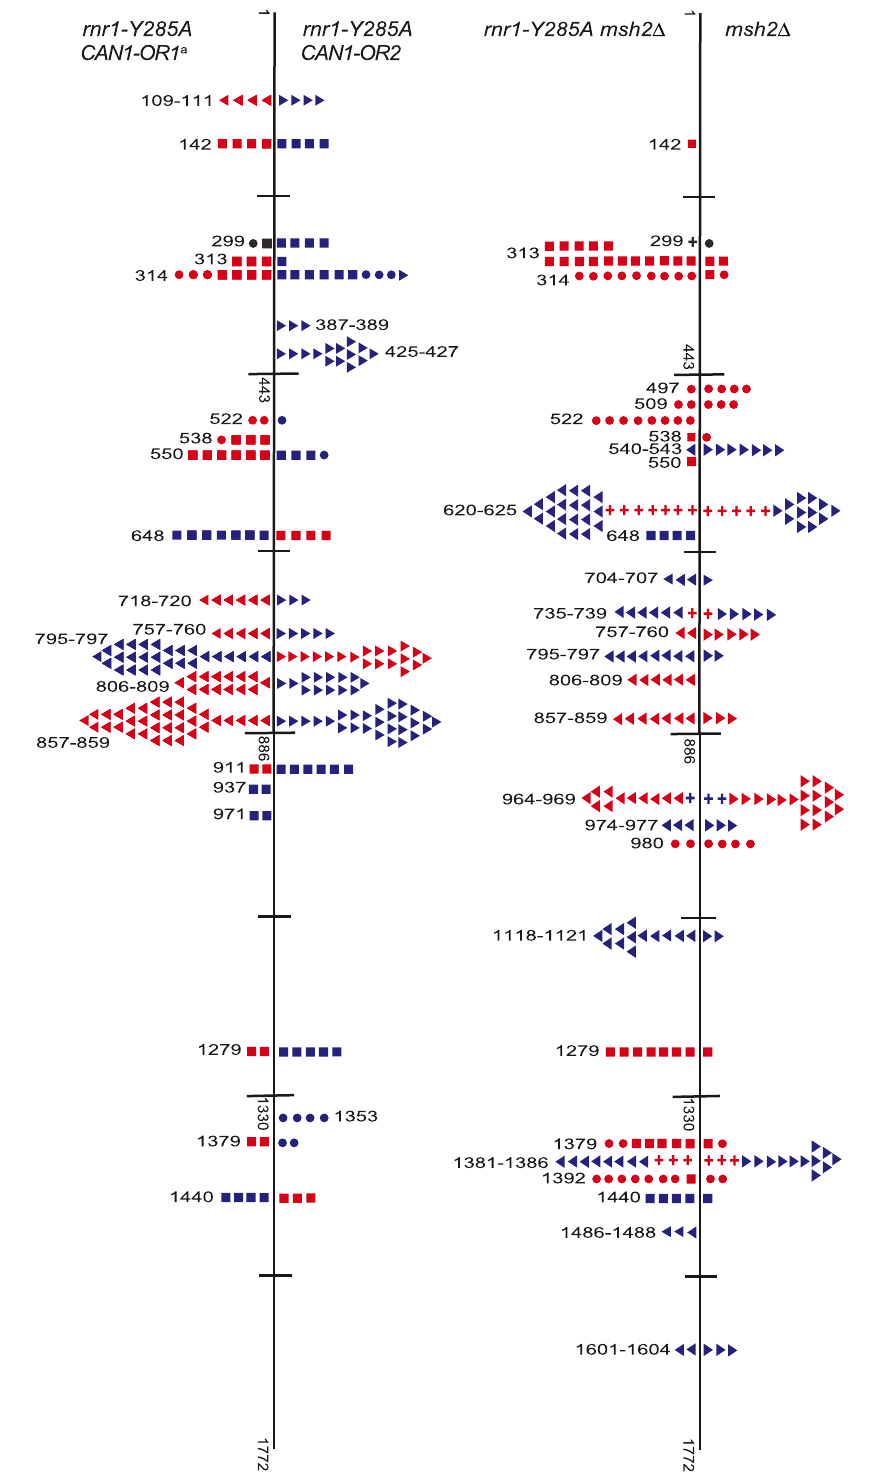
Figure 4. Simplified CAN1 mutation spectra showing hotpots (where mutation rate is greater than 10-fold that in wt) for rnr1-Y285A CAN1-OR1 (n=173), rnr1-Y285ACAN1-OR2 (n=170), rnr1-Y285Amsh2 D (n=259), and msh2 D (n=164) where n= number of individual colonies sequenced. Symbols indicate the following: plus - additions, triangles - deletions, squares - transversions, circles - transitions, red - occur during leading strand synthesis, blue - occur during lagging strand synthesis, black - mutation cannot be assigned to a strand. a Reanalysed from the dataset published in [17].